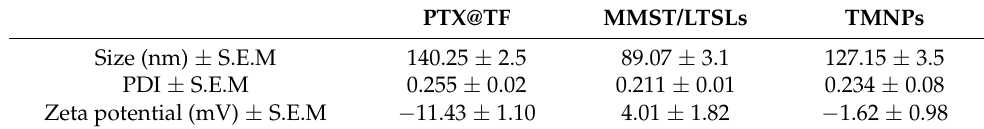
Table 1. Average particle size, PDI and surface potential of PTX@TF, MMST/LTSLs and TMNPs.